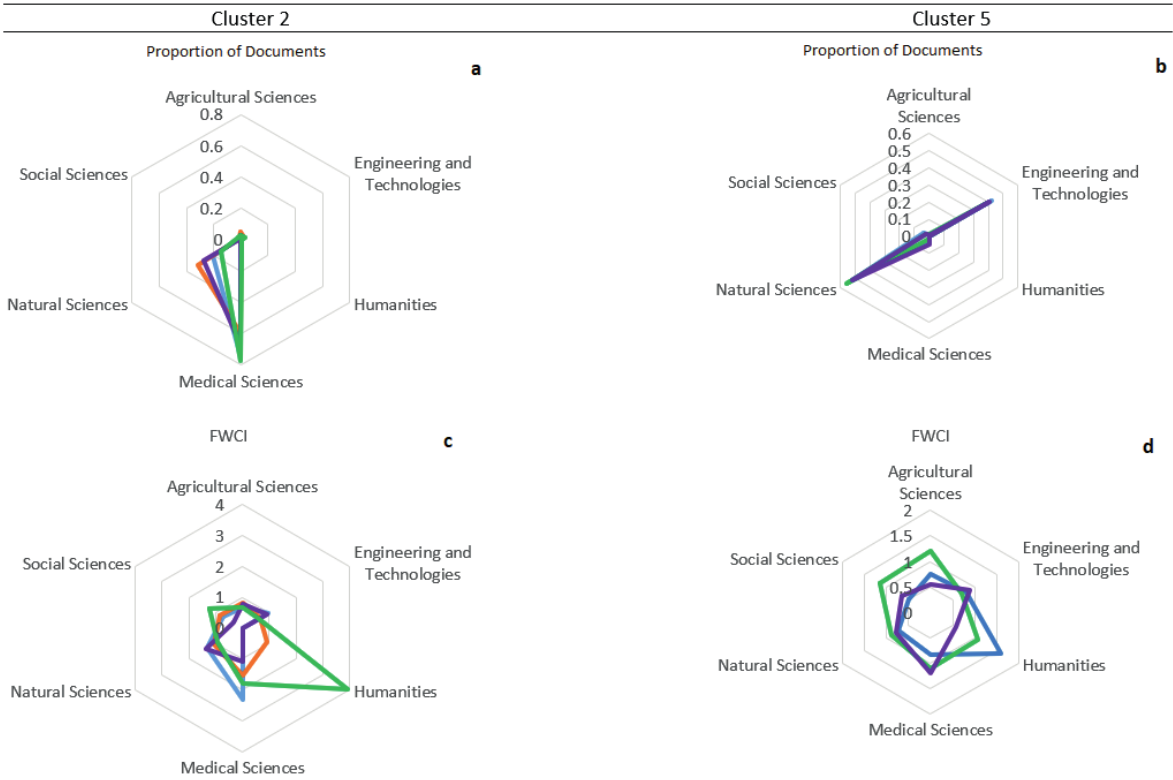
Figure 6. Proportion of documents (a and b) and Field Weighted Citation Index (FWCI) (c and d) for four different hospitals (Cluster 2) and three different engineering institutions (Cluster 5). (Cluster 1 has highest impact factor and Cluster 5